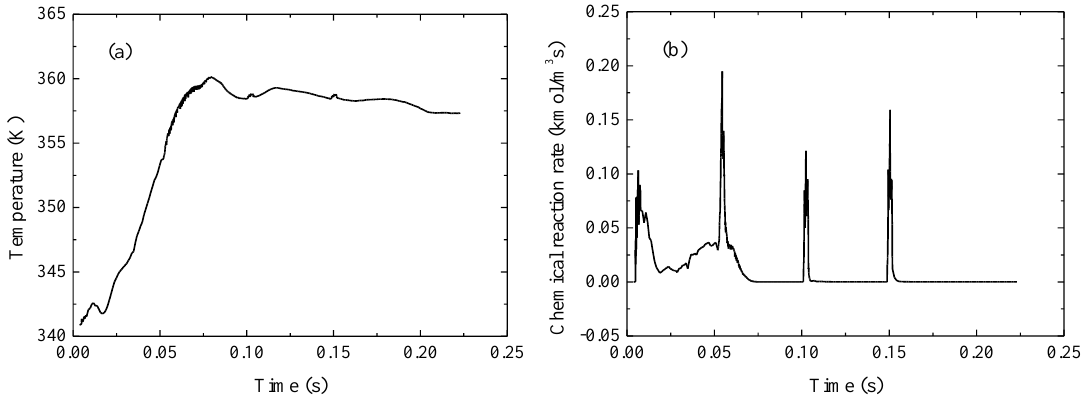
Figure 16. The changes of combustor ( a ) average temperature and ( b ) chemical reaction rate with time in Case